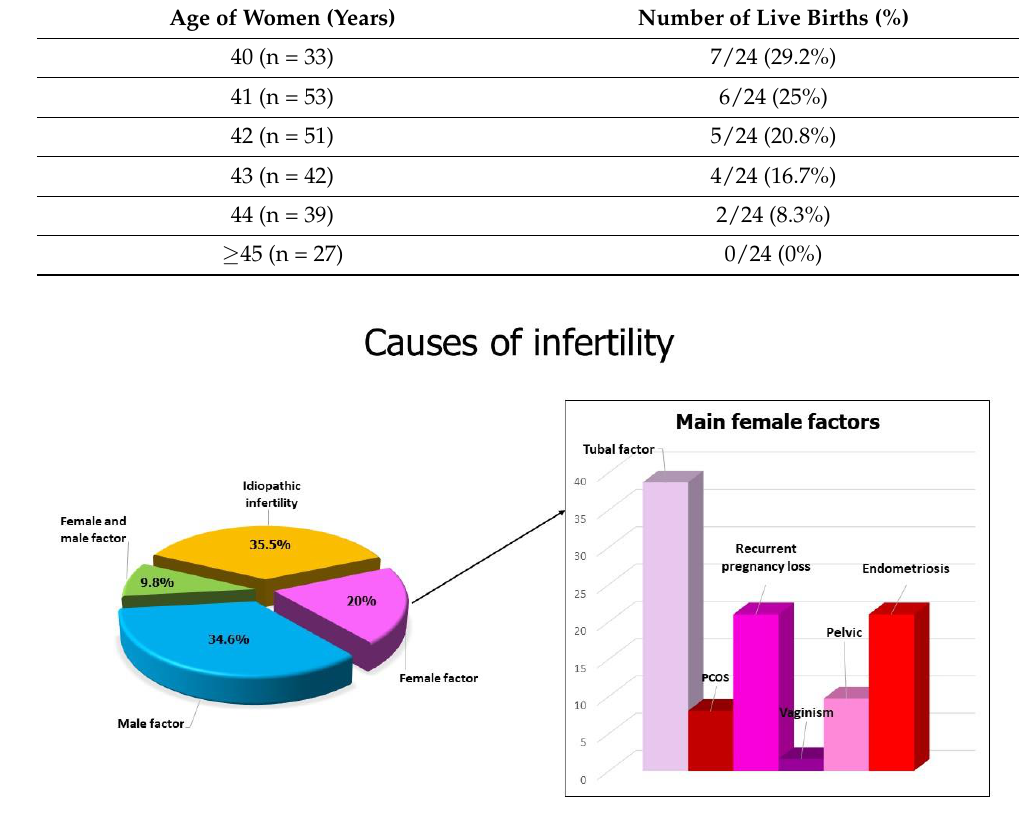
Figure 1. ( Left panel ): Main causes of infertility found in the 184 couples enrolled in this study. ( Right panel ): Detail of the main causes of female infertility.